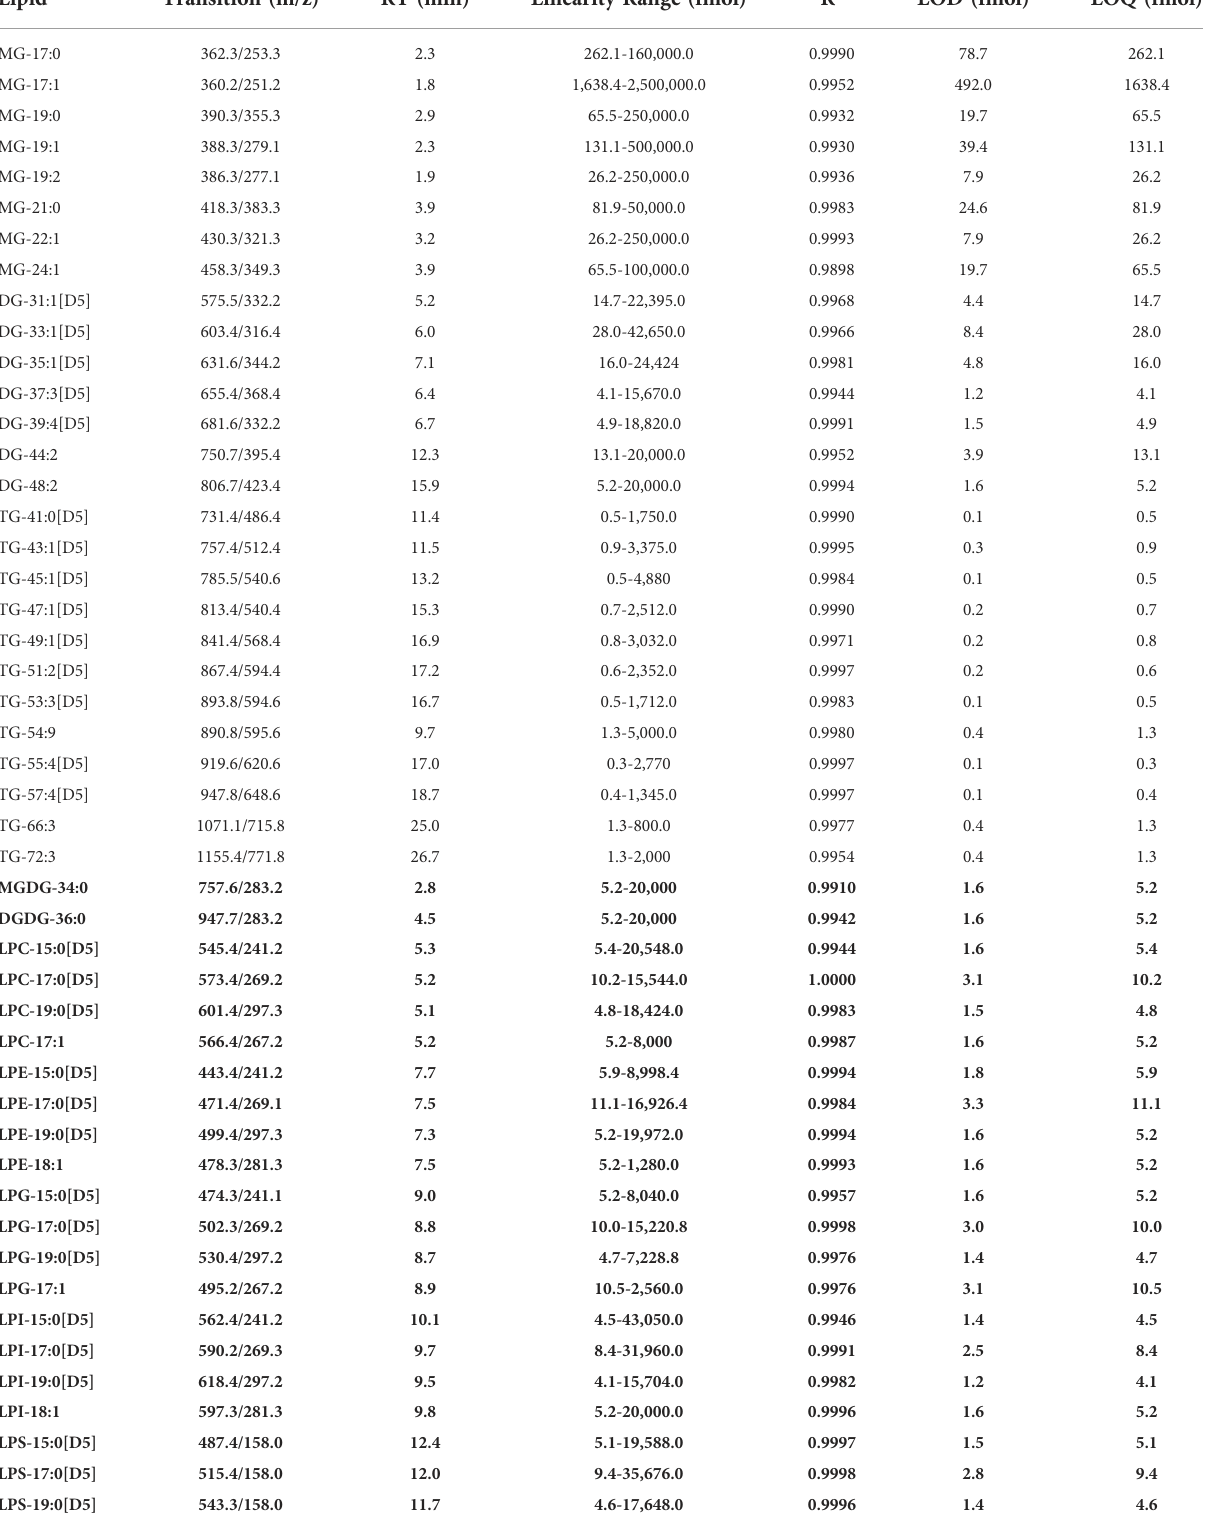
TABLE 3 LC-MS/MS method sensitivity and linearity for non-polar and polar lipids.